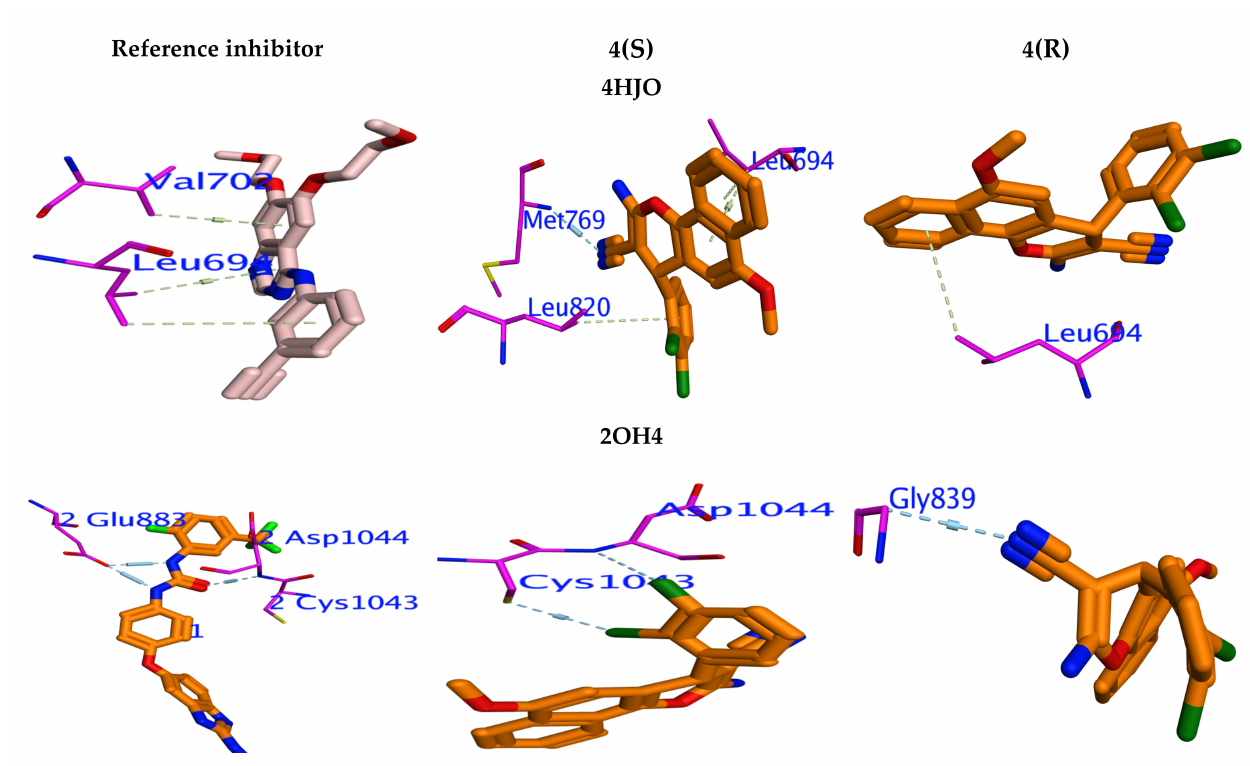
Figure 6. Binding approach of stereoisomers for compound 4 and reference inhibitors into 4HJO and 2OH4. H-bonds are represented with blue